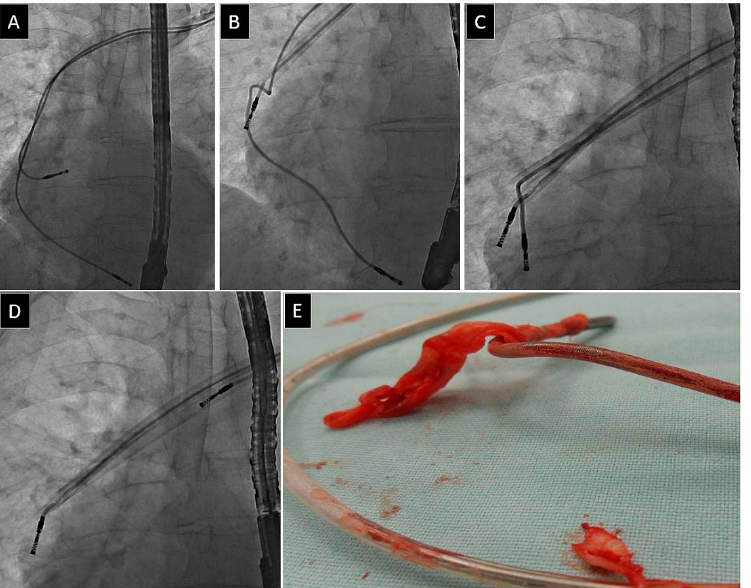
Figure 5. Lead-on-lead binding. The strong fibrous encapsulation prevents further advancement of the wire to free the lead ( A , B ). Sometimes it is necessary to use two polypropylene sheaths, which act together as scissors to separate the leads ( C , D ). Lead removed from the circulatory system, connective tissue remnants ( E ). Lead fracture was the third most frequent UPD, as it occurred in 143 patients (3.84%).